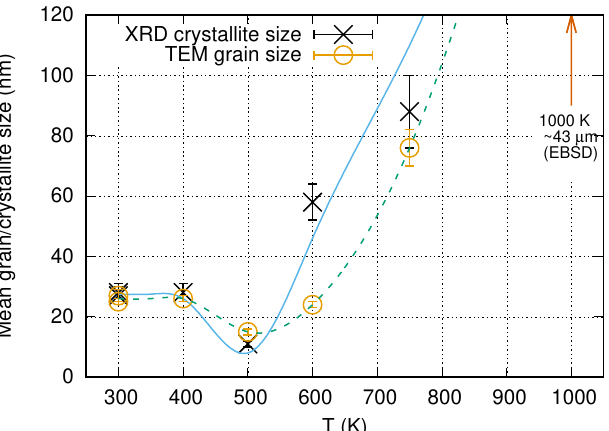
Figure 9. Grain size determined by TEM and crystallite size obtained by XLPA for the “es” side of the film CYS04 versus the annealing temperature. The line serves as a guide for the eye only.